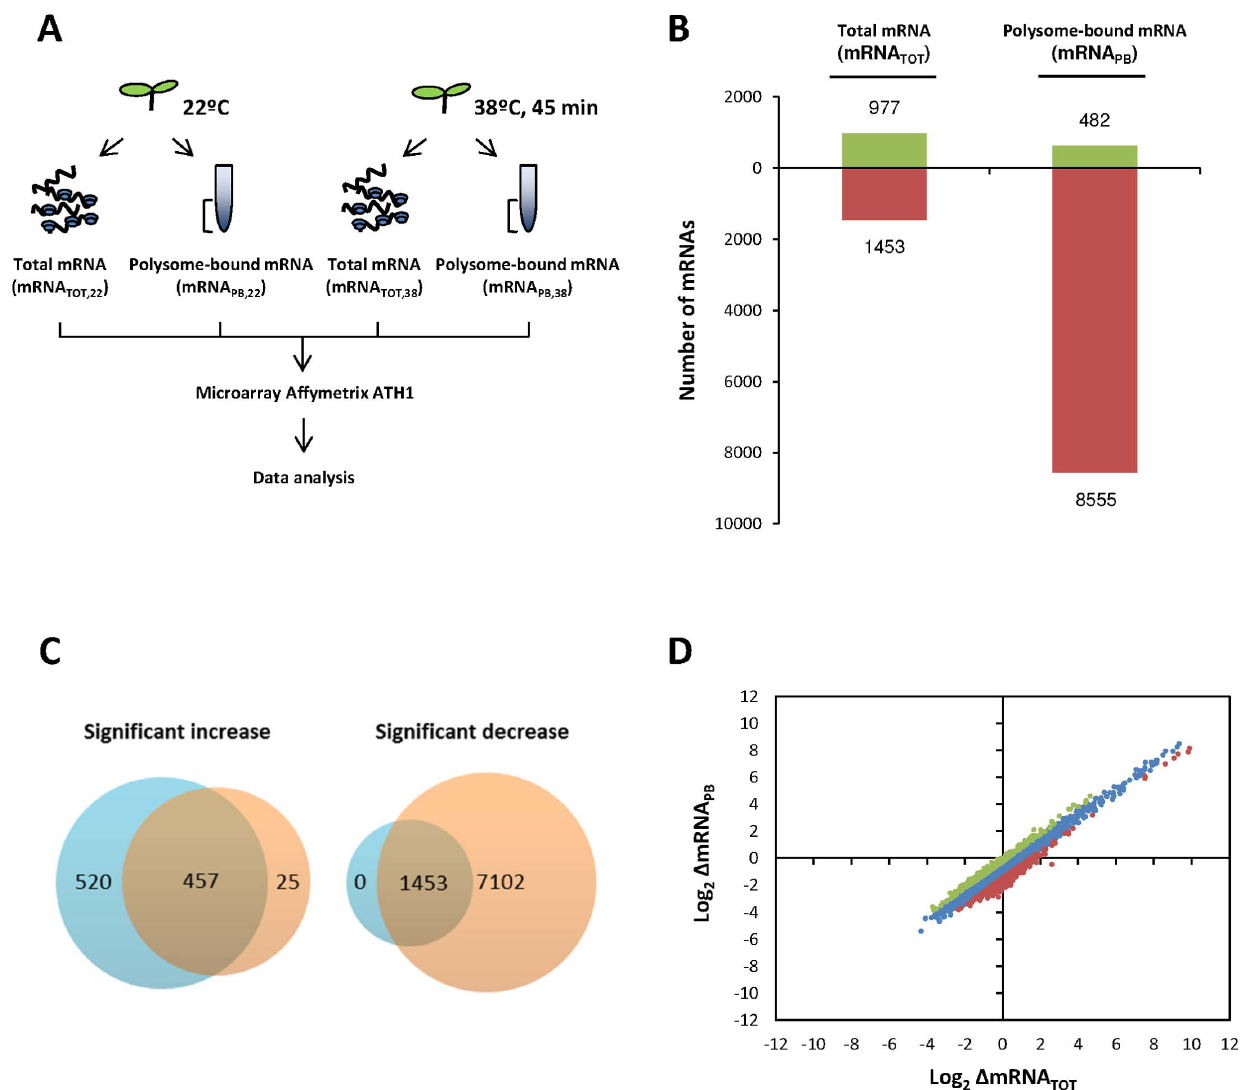
Figure 2. Comparison of heat-induced changes in steady-state and polysome bound mRNAs from Arabidopsis seedlings. ( A ) Illustration of the experimental design. Total and polysome-bound mRNA from control or heat-stressed seedlings were isolated in parallel for microarray hybridization to Arabidopsis whole-genome Affymetrix ATH-1 platform and subsequently analyzed. (B) Graphic representation of the number of mRNAs with $ 2-fold variations in steady-state levels (mRNA TOT ) or in polysome association (mRNA PB ) in response to the heat treatment. Green and red colors represent upregulated and downregulated mRNAs under heat stress, respectively. ( C ) Venn diagrams of heat-stress upregulated and downregulated mRNAs. mRNAs that only experienced significant variations in steady-state levels ( $ 2-fold variations in mRNA TOT , FDR , 0.05) are shown in blue, those that only experienced significant changes in their association to polysomes ( $ 2-fold variations mRNA PB , FDR , 0.05) are shown in red. Merged section included those transcripts that significantly changed at both, transcriptional and translational, levels ( $ 2-fold variations in mRNA TOT and mRNA PB , FDR , 0.05) in response to the heat treatment. ( D ) Genome-wide comparison of the heat-induced changes in the transcriptome (x-axis, log 2 D mRNA TOT ) and the translatome (y-axis, log 2 D mRNA PB ). The log 2- values of the fold changes were plotted for all the probe sets included in the Affimetrix ATH-1 microarray (n=22810). mRNAs with an average translation efficiency (log 2 D mRNA PB / D mRNA TOT ) are shown in blue, while mRNAs with $ 1.5 or # 1.5 fold the average translation efficiency are shown in green and red,